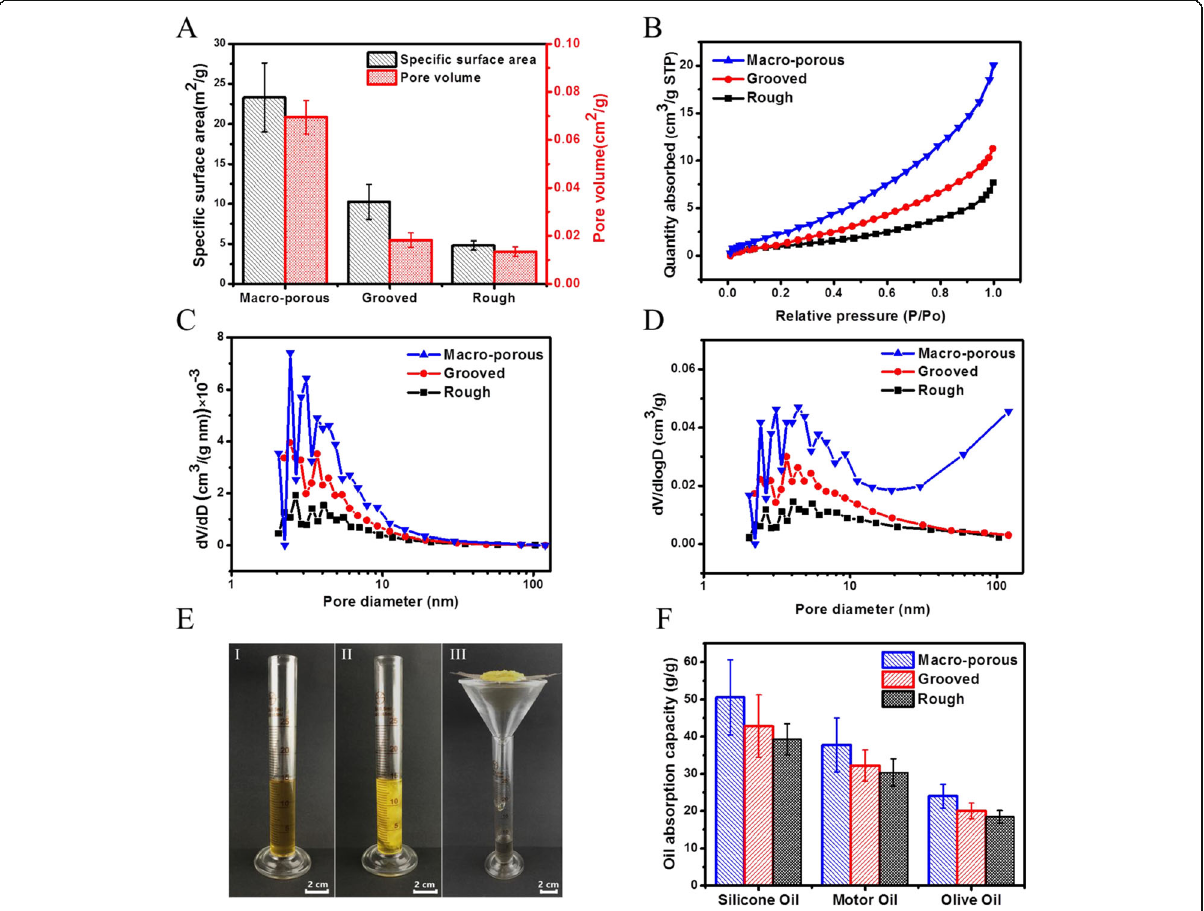
Fig. 9 Characterizations of the macro-porous, grooved, and rough fibers. a Specific surface area and pore volume. b The nitrogen adsorption isotherms. c dV/dD — pore diameter curve. d dV/dlogD — pore diameter curve. e Pictures of oil absorption. (I) 15 mL of water-oil mixture (1:1) without sorbent, (II) during absorption, (III) during draining. f Oil absorption capacities